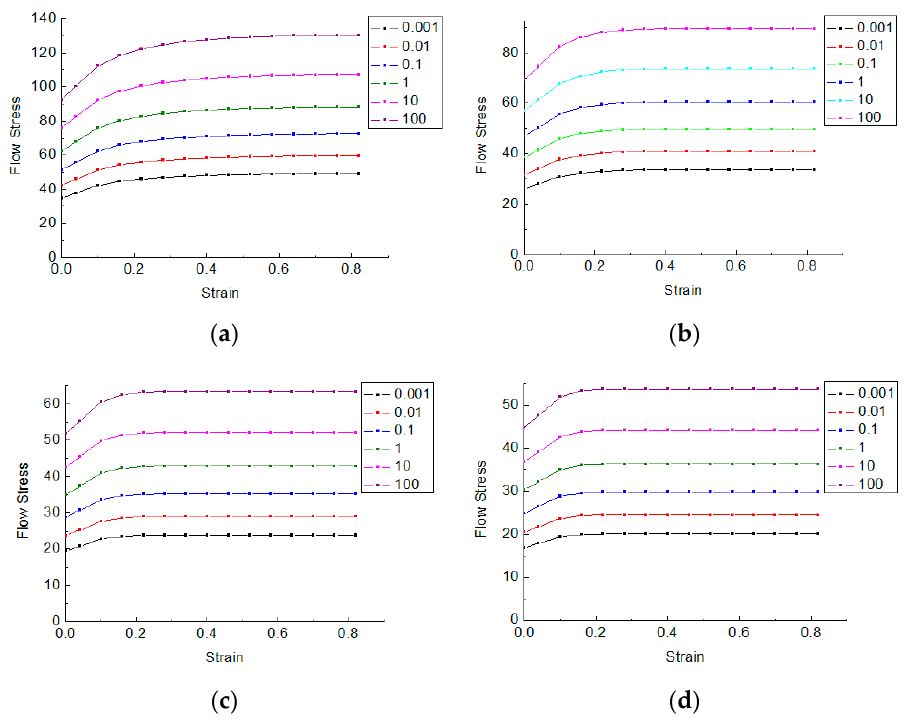
Figure 4. Flow stress–strain curves for AA6082 alloy under different temperature: ( a ) 300 °C; ( b ) 400 °C; ( c ) 500 °C; ( d ) 550 °C.